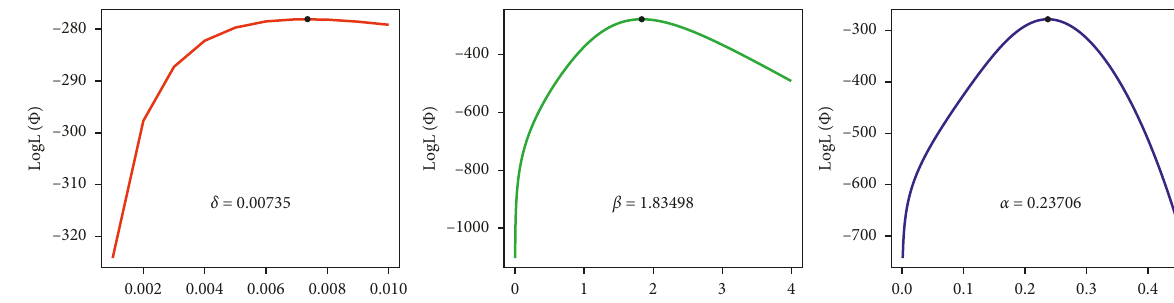
Figure 4: Basic plots of Data 1.